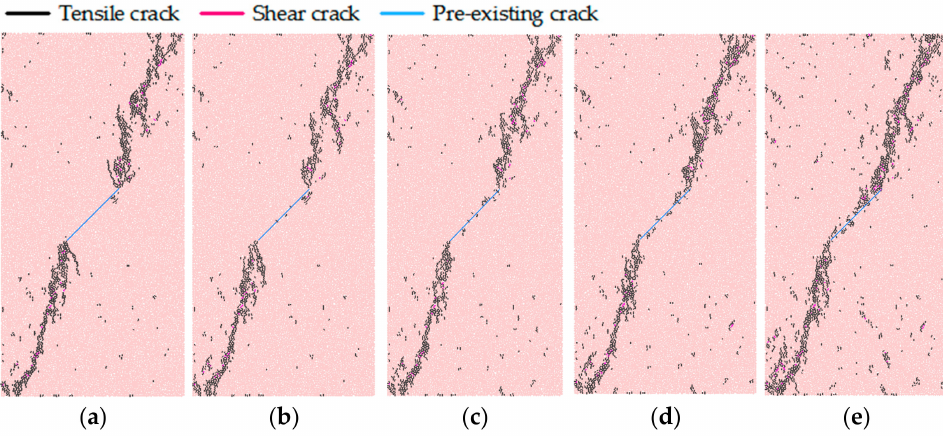
Figure 13. Cracks distribution in the main crack bearing granite at the moment of peak strength considering different friction coefficients: ( a ) µ = 0; ( b ) µ = 0.25; ( c ) µ = 0.5; ( d ) µ = 0.75; ( e ) µ =